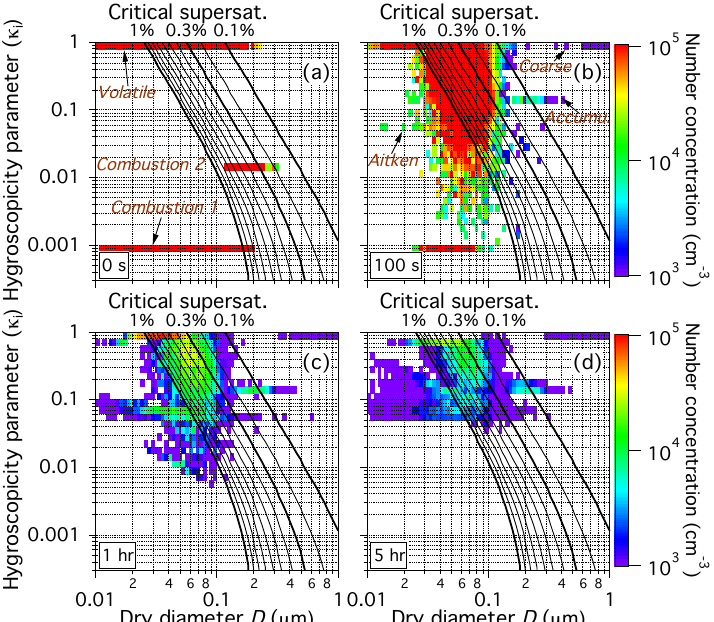
Figure 8. Two-dimensional number distribution n κ (D, κ) (base case, condensation and coagulation included) at 0s, 100s, 1h, and 5h. The 2-D distribution is defined in Eq. (13).